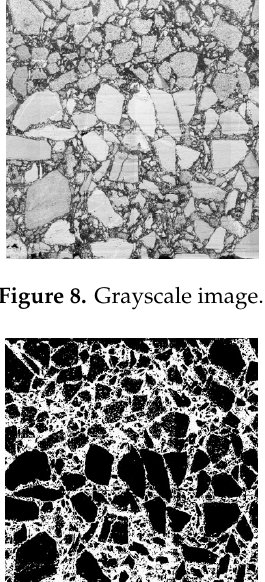
Figure 9. Binarized image.